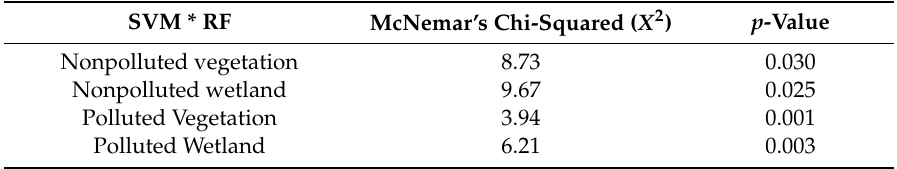
Table 8. McNemar’s Chi-Squared ( X 2 ) Test Value with Associated Probability Value ( p -value) for the Study